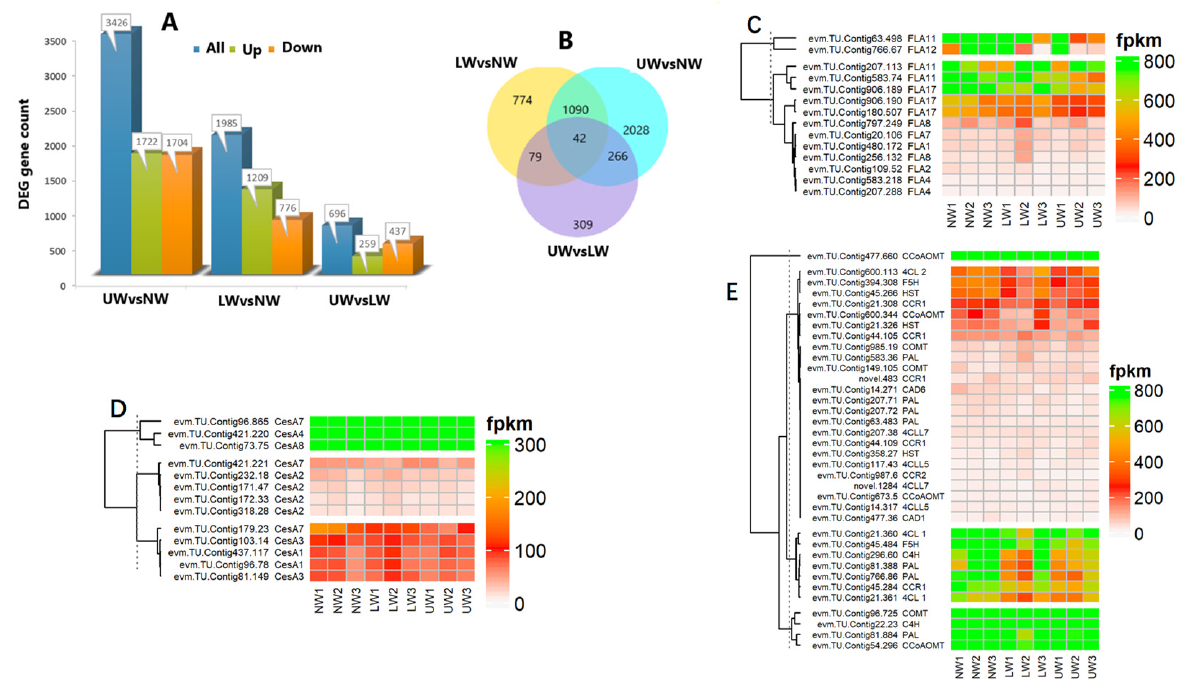
Figure 3. Differential expression of significant genes. ( A ) Number of DEGs up- or downregulated in the studied wood samples. ( B ) Venn diagram showing shared and unique unigenes among different studied samples. ( C ) Differential expression of FLA genes. ( D ) Expression of cellulose synthesis-related genes. ( E ) Differential expression of genes responsible for lignin biosynthesis.